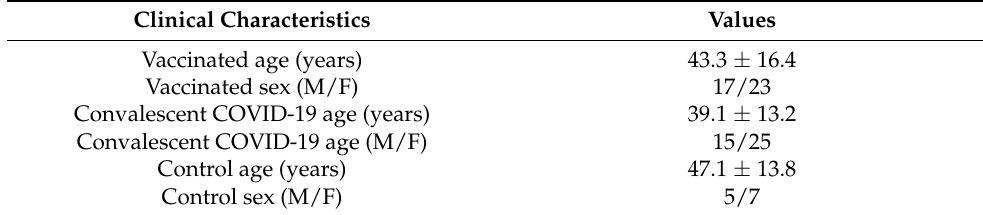
Table 4. SputnikV vaccinated and controls demographics information. Clinical Characteristics